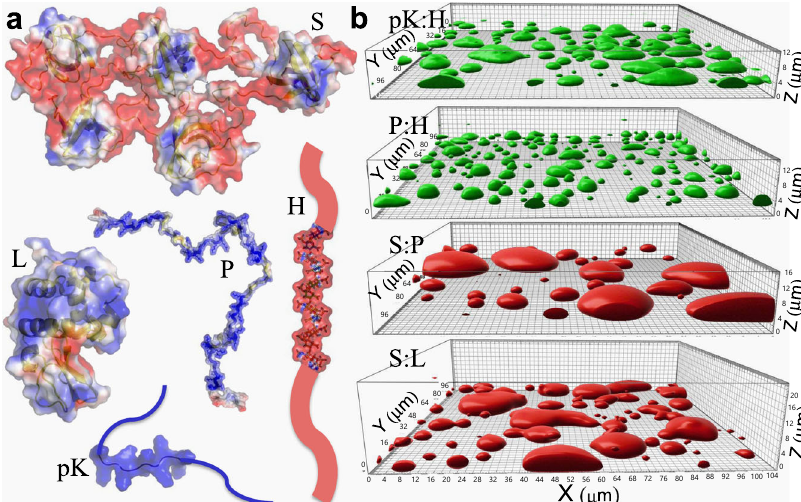
Fig. 1 Macromolecular components and the resulting four types of droplets. a Molecular structures of pentameric constructs of SH3 domains (S) and proline-rich motifs (P), lysozyme (L), heparin (H), and polylysine (pK), rendered by electrostatic surfaces (blue and red: positive and negative electrostatic potentials, respectively). L is fully folded, P, H, and pK are fully disordered, and S contains both folded domains and disordered linkers. b pK:H, P:H, S:P, and S:L droplets settled on a coverslip, visualized by the fl uorescence of either FITC-labeled H (green) or Alexa 594-labeled S (red), reproduced from ref. 26 . The growing tallness of droplets in the series gives a crude indication of a modest increase in interfacial tension from pK:H to